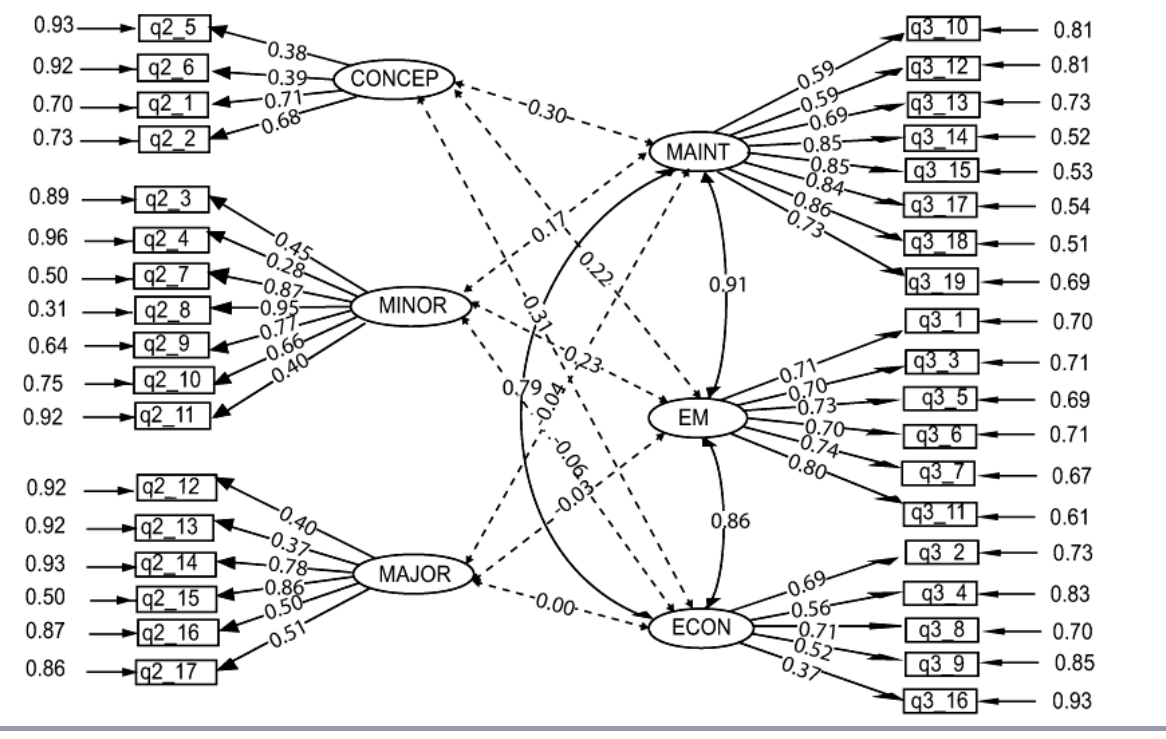
Fig. 4 . Correlations between forest owner representations of forest management (MAINT, EM, and ECON) and perceived cutting constraints (CONCEP, MINOR, and MAJOR) shown as two-headed dashed arrows. All parameters significant at P < 0.05. MAINT = maintenance forest management; EM = ecosystem-centered management; ECON = economics-centered management; CONCEP = conceptual constraints; MINOR = physical constraints; MAJOR = potentially removable